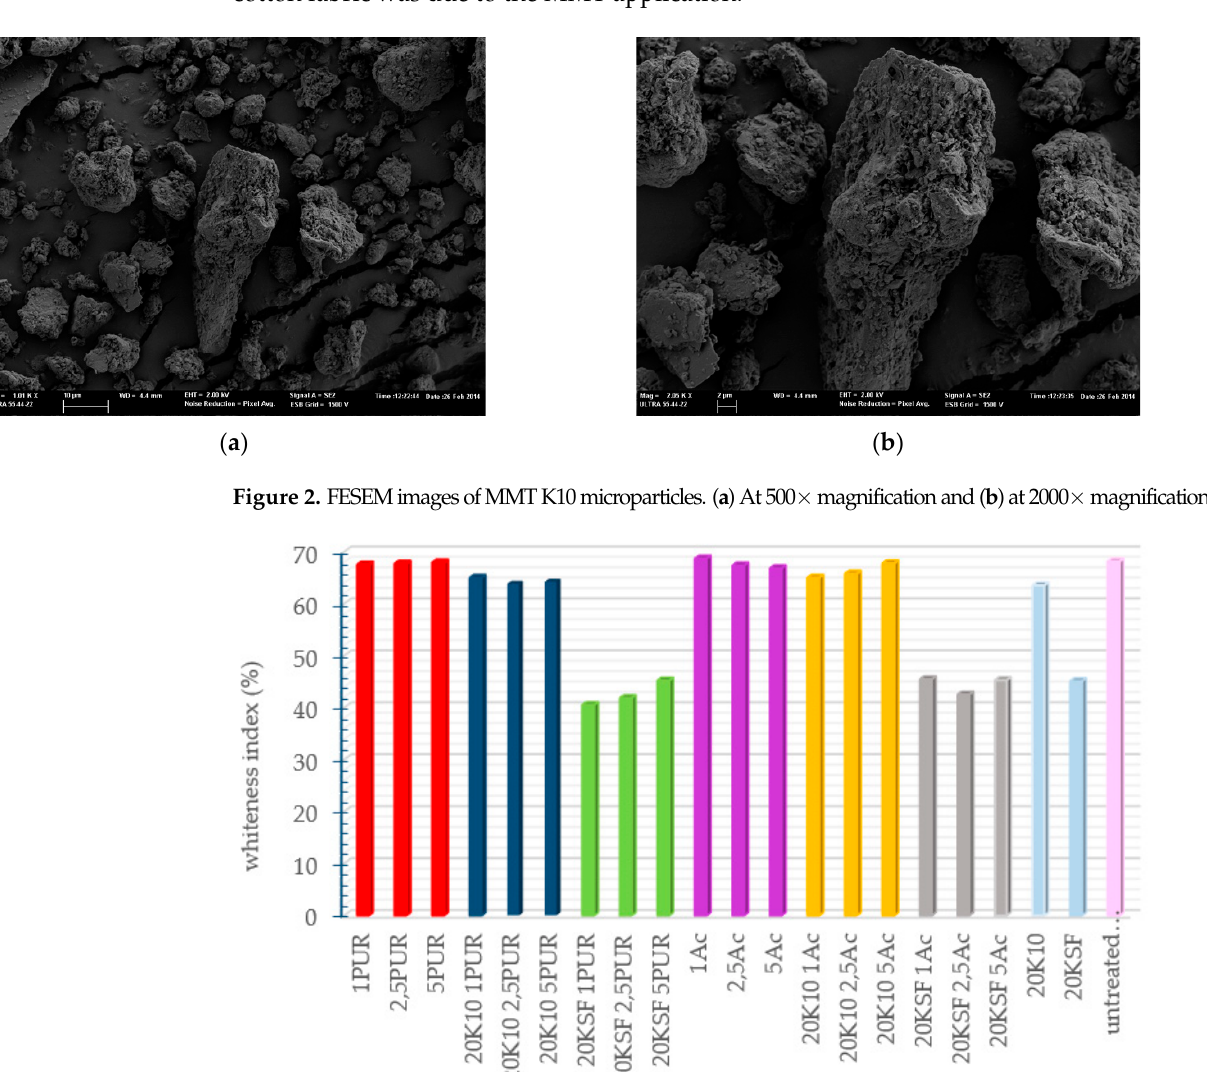
Table 3. CIELAB color space colorimetric parameters of the treated samples.